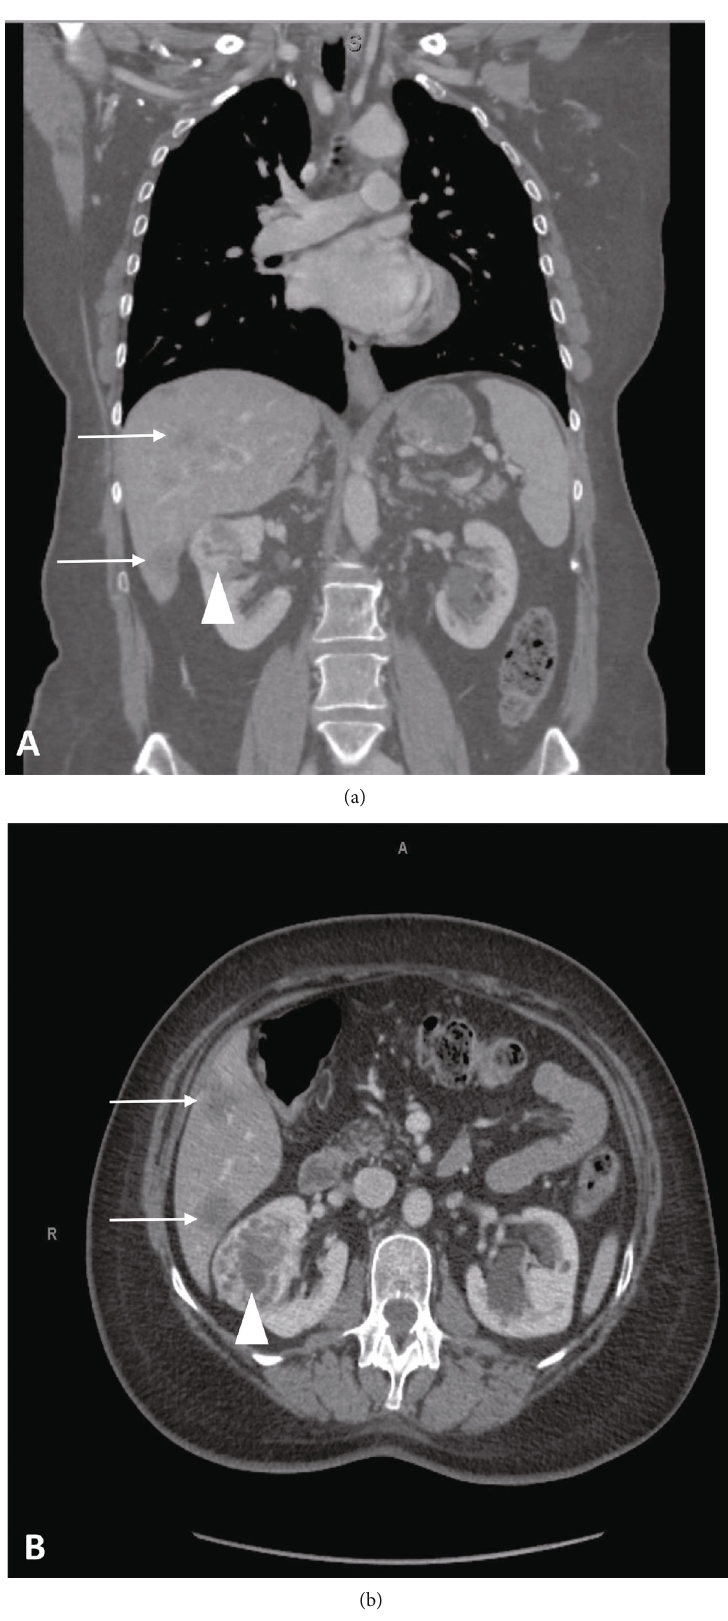
Figure 2: Abdominal CT scan with right renal mass (white arrowheads) and liver metastases (white arrows). (a) Coronal section. (b) Transverse